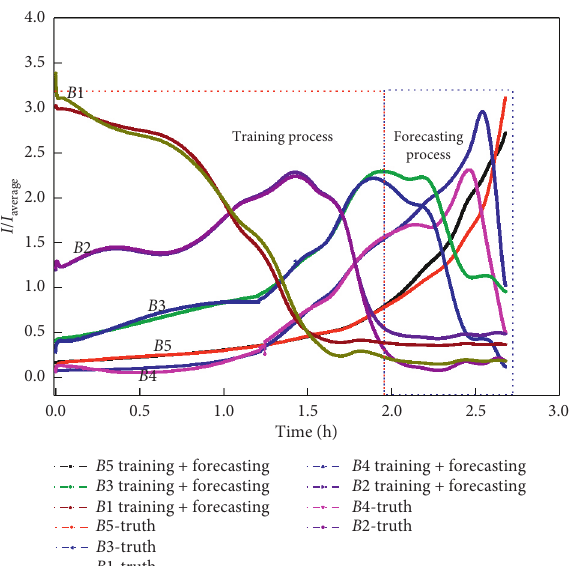
Figure 3: Actual and forecasting current scenario of parallel branch.